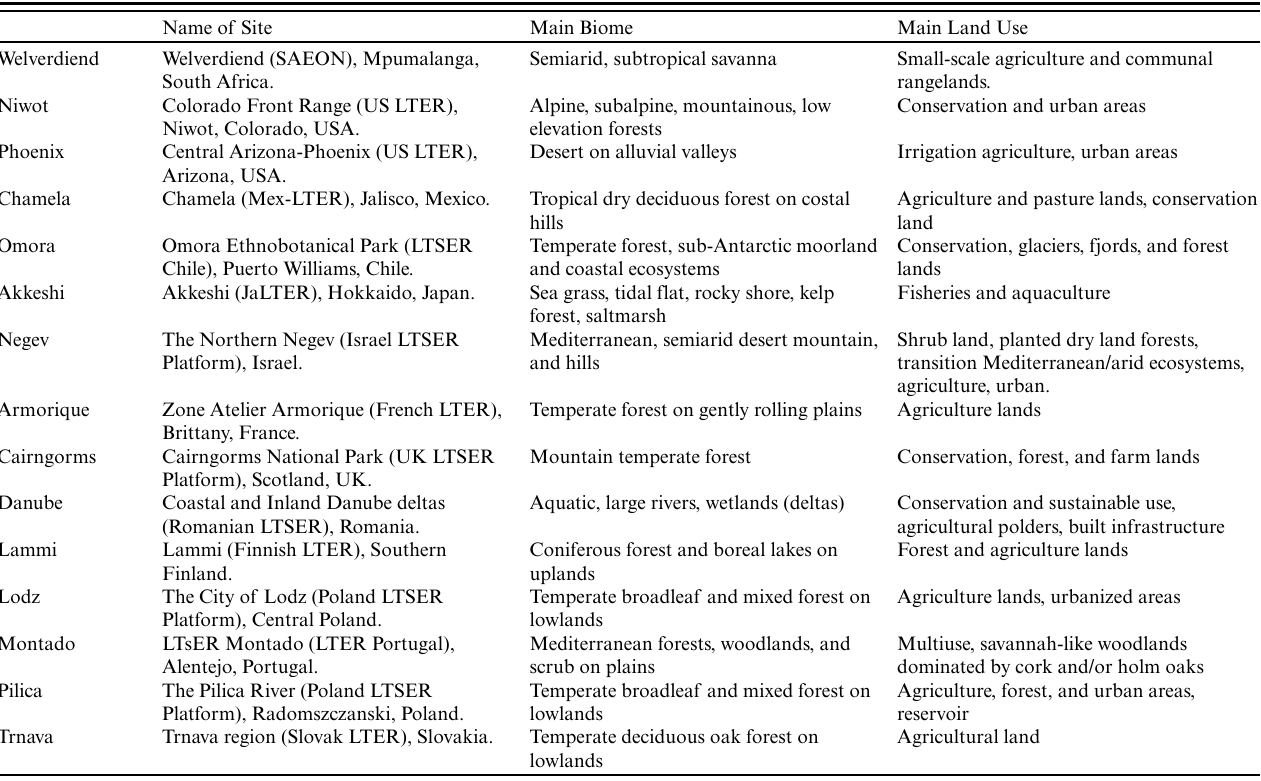
Table 1 . International Long-Term Ecological Research network (ILTER) potential participant sites in an ILTER/Programme on Ecosystem Change and Society (PECS)